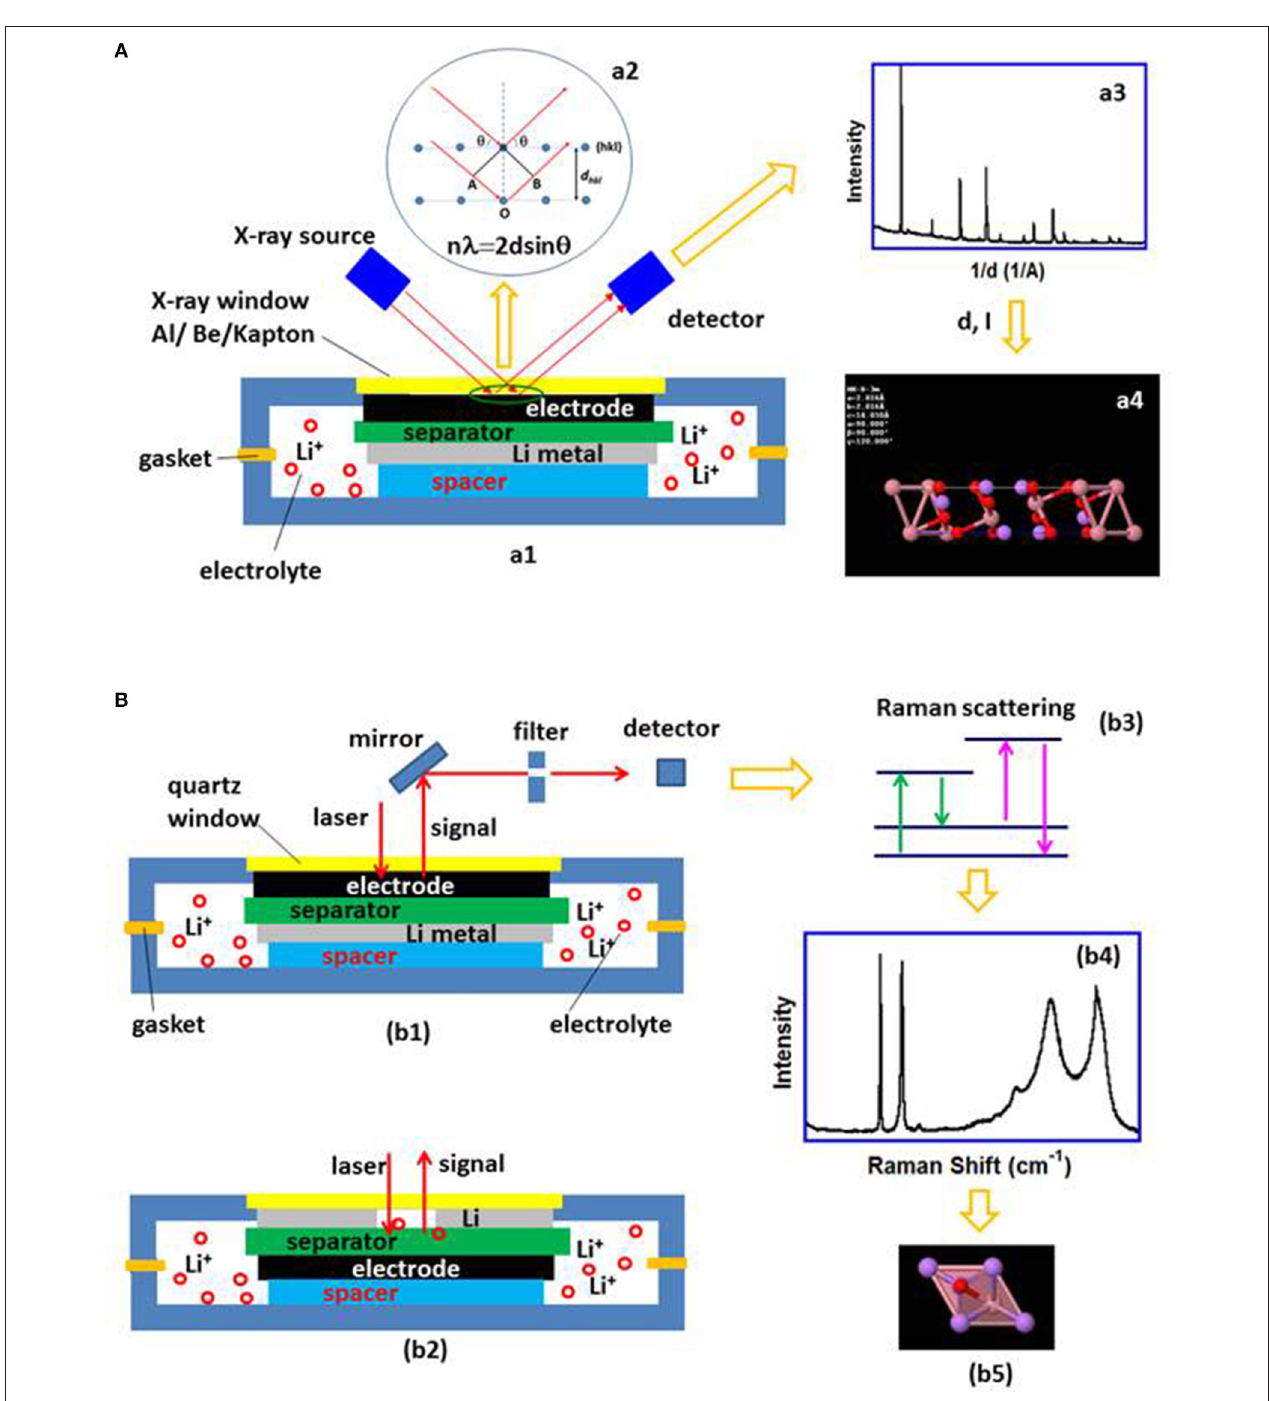
FIGURE 1 | (A) A schematic diagram of the principle of X-ray diffraction analysis; (a1) in situ XRD cell design; (a2) The incident X-ray satisfying Bragg’s law is diffracted; (a3) The diffracted X-ray is plotted as a function of Intensity vs. d-spacing or 2 θ ; (a4) Determination of the crystal structure from the spectrum. Schematic diagrams of the in-situ Raman cells for analyzing the electrode surface and electrolyte on the lithium metal side or separator surface are plotted in (b1,b2) respectively; (b3) shows the Raman signal is collected after filtering the other radiation out and expressed as a function of Intensity and Raman shift (b4) from which the local structure information can be obtained (b5)